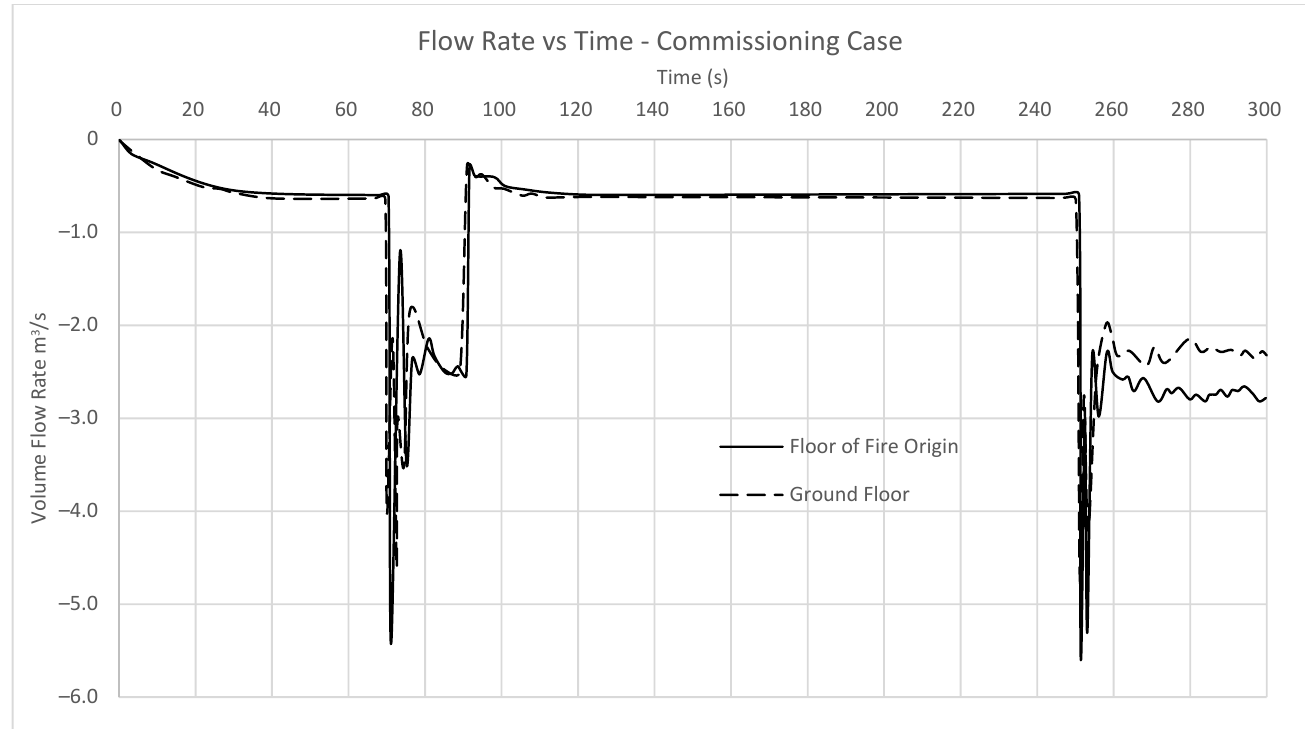
Figure 5. Volume flow throughout stairs of interest for commissioning case.